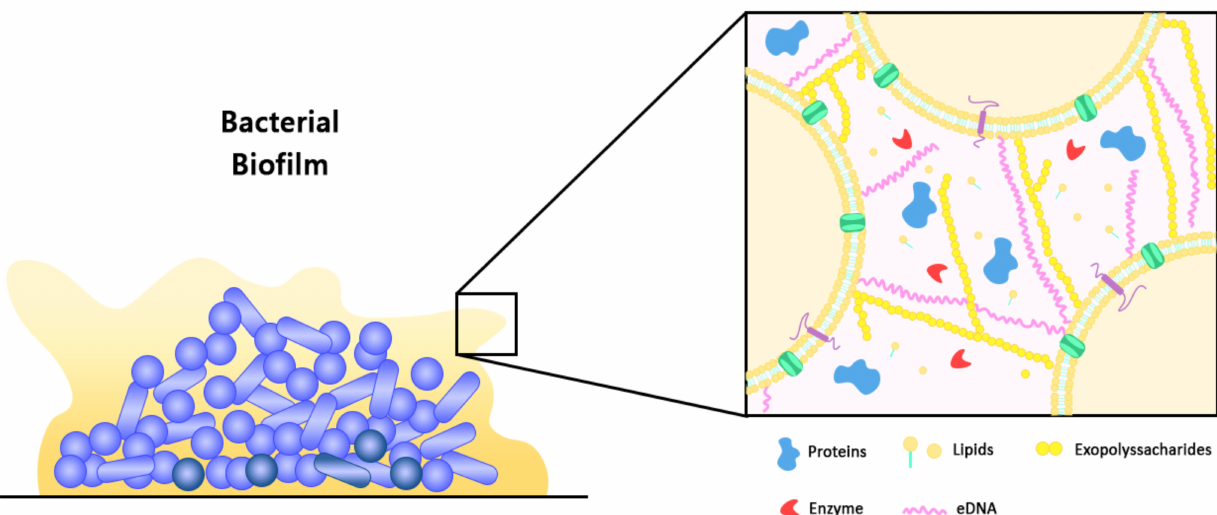
Figure 1. Schematic representation of a bacterial biofilm and its extracellular polymeric substance (EPS). Microcolonies of a mature biofilm are typically characterized by the presence of an EPS matrix that is composed of exopolysaccharides, proteins, extracellular DNA (eDNA), lipids, and enzymes. The EPS matrix acts as a protective barrier to shield the microbial community from external threats, including those of host defense mechanisms and antimicrobial therapeutics